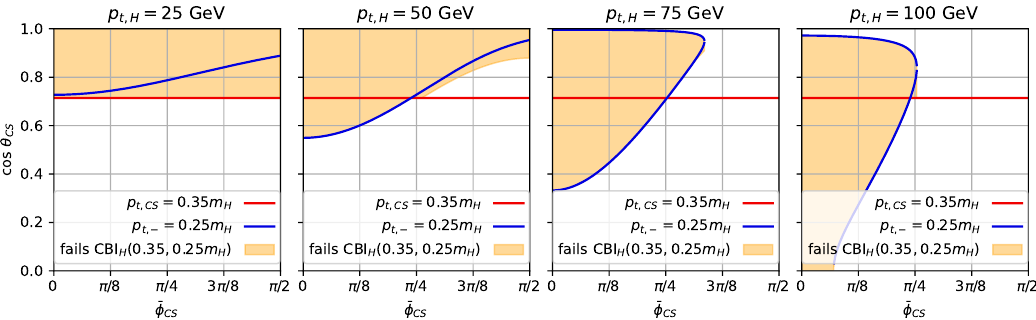
Figure 11 . Action of the hardness-compensating boost-invariant (CBI H ) cuts in the ¯ φ cs – θ cs plane, as compared to the p t, cs and p t, − cuts of section 3.5, whose action was shown in figure 10. cos θ = 1 . This occurs when the second solution for sin θ cs that yields p CS